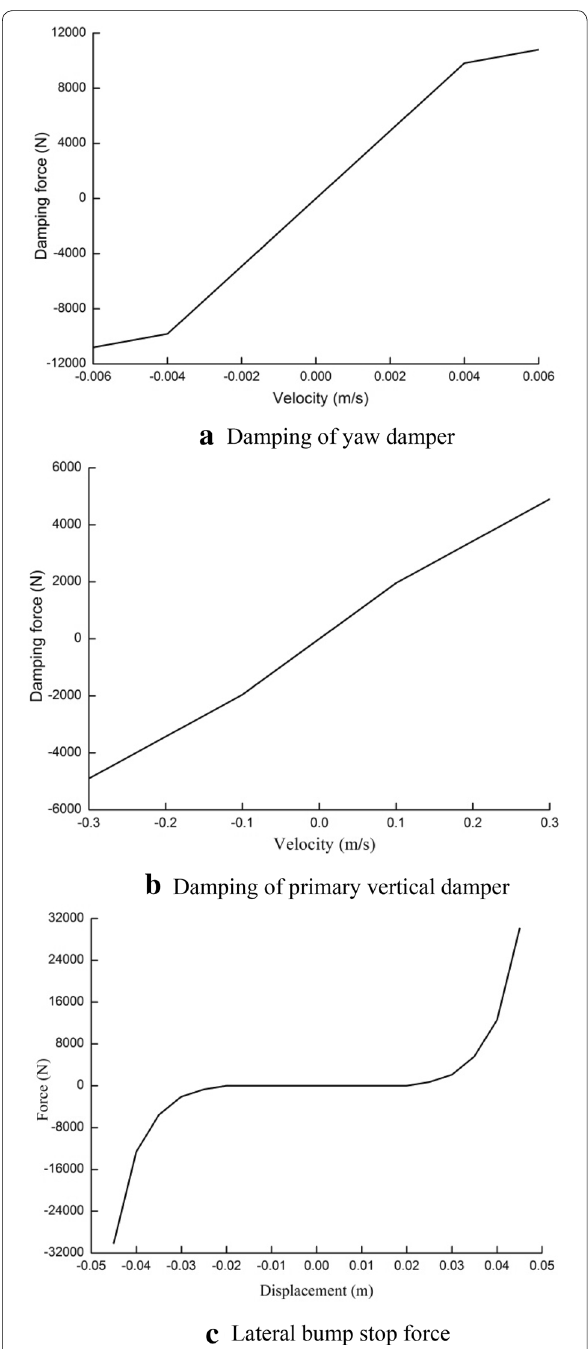
Figure 4 Non-linear characteristics of mechanism